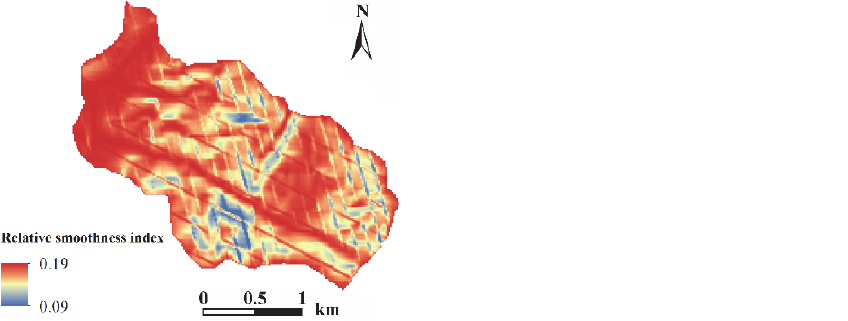
Figure 2. Spatial distribution of weighting factors (relative smoothness index) in Xiangchagou wa ‐ tershed.